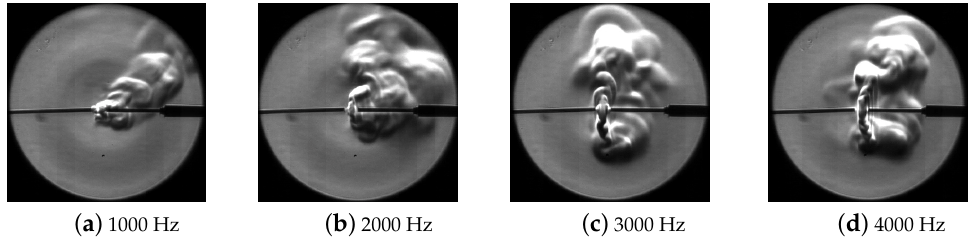
Figure 6. High-speed schlieren imaging of PDD at differet repetition